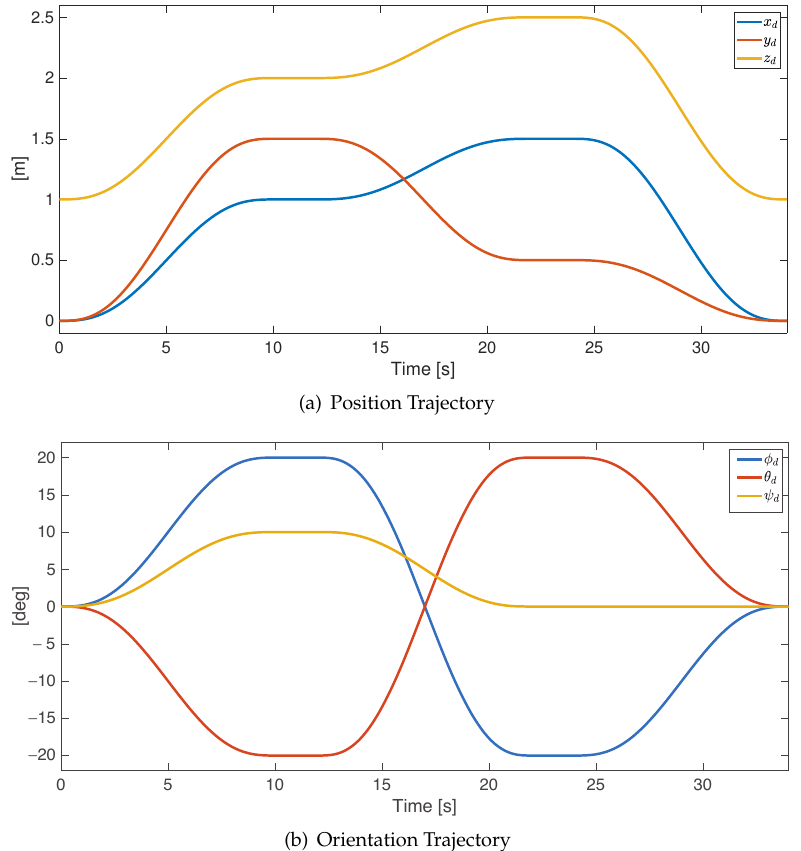
Figure 3. First case study: desired position and orientation trajectories for the platform. The obtained results are reported in Figure 4a,b in terms of position ( p − φ orientation ( φ ) errors. In both cases, satisfactory performance is achieved, since the 0, d 0 maximum position error is about 5 mm along the axes x and y and 15 mm along the z axis, while the orientation error oscillates around zero, with some peaks below 5